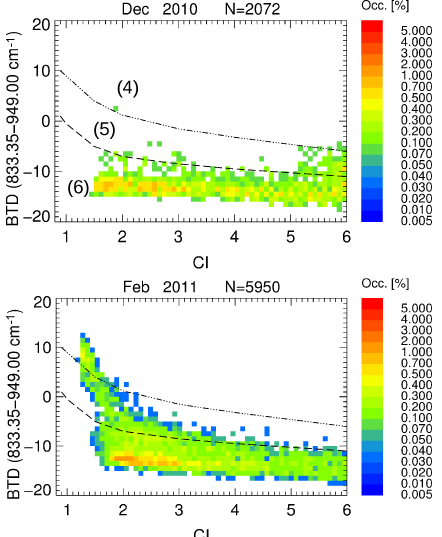
Figure 5. MIPAS 2-D PDF distribution of cloud index (CI) vs. BTD 833 − 949 for the December 2010 (top) and February 2011 (bot- tom) measurement periods in the NH Arctic polar cap region (north of 55 ◦ N) in the altitude range 16–30km. Superimposed separation functions (dashed-dotted and dashed lines) are retrieved from the CSDB in Fig. 4 and are highlighting region (4) for ice (acronym ICE ci in Table 2), region (5) for ice with overlap of small NAT par- ticle emissions (ICE ci _ s NAT1), and region (6) for the overlap of STS with large NAT (STS ci _ l NAT2) particles (bottom region).